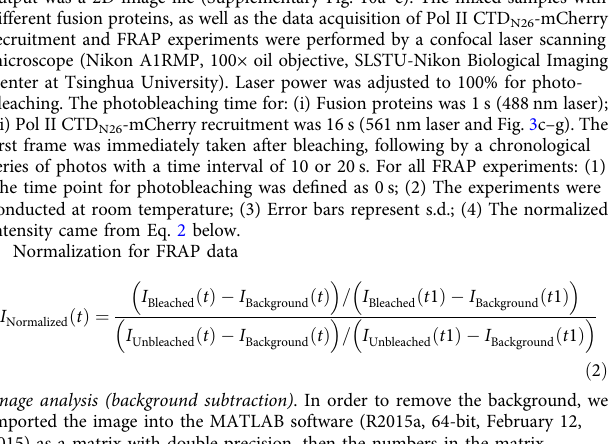
Fig. 7 The model. A schematic concept of a biophysical mechanism involving loci-speci fi c biomolecular condensates of FET fusion oncoproteins promoting aberrant gene Gal4DBD binding sites were visualized by a Nikon inverted microscope (Ti- Eclipse) with a 90× oil objective and a camera (HAMAMATSU ORCA-Flash4.0 V3 Digital CMOS camera C13440-20CU, Yihan Lin Lab at Peking University), and the output was a 2D image fi le (Supplementary Fig. 10a – c). The mixed samples with different fusion proteins, as well as the data acquisition of Pol II CTD N26 -mCherry recruitment and FRAP experiments were performed by a confocal laser scanning microscope (Nikon A1RMP, 100× oil objective, SLSTU-Nikon Biological Imaging Center at Tsinghua University). Laser power was adjusted to 100% for photo- bleaching. The photobleaching time for: (i) Fusion proteins was 1s (488nm laser); (ii) Pol II CTD N26 -mCherry recruitment was 16 s (561nm laser and Fig. 3c – g). The fi rst frame was immediately taken after bleaching, following by a chronological series of photos with a time interval of 10 or 20 s. For all FRAP experiments: (1)